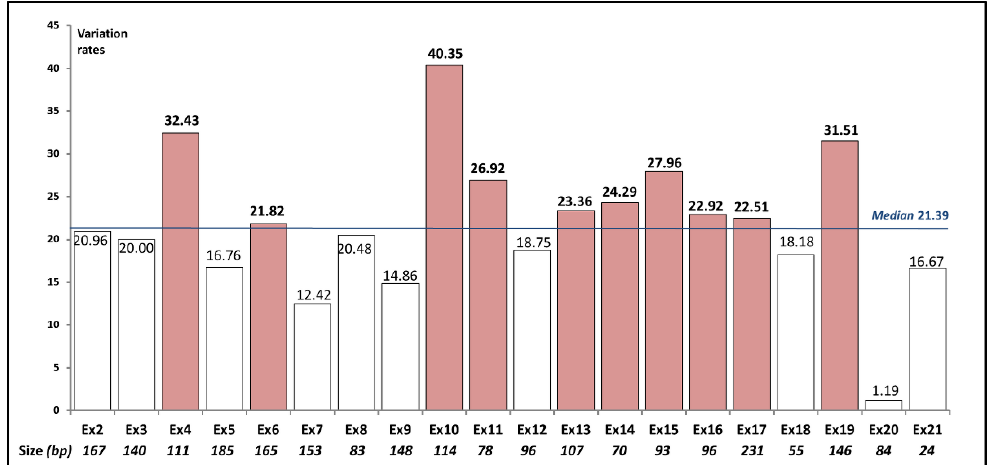
Figure 3. The PLP variation rates in the SLC26A4 coding exons. The exons with the variation rates above the threshold (median = 21.39) are colored.